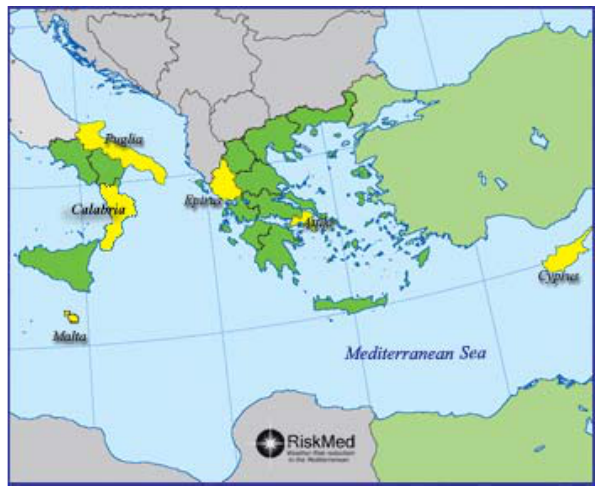
Fig. 1. The target areas of the RISKMED project (in yellow).